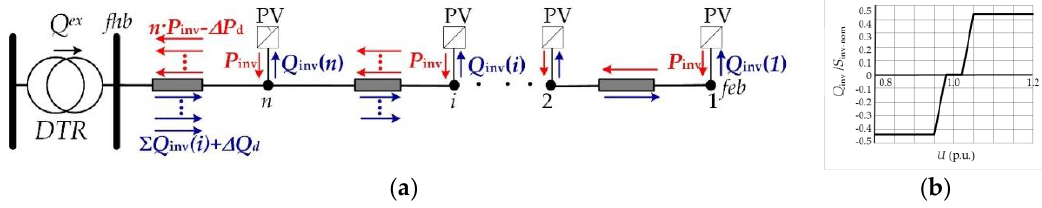
Figure 11. Schematic presentation of the power flows when Q ( U ) is applied: ( a ) the active and reactive power flows supplied by the PV inverters; ( b ) Q ( U ) characteristic set by all of the inverters.